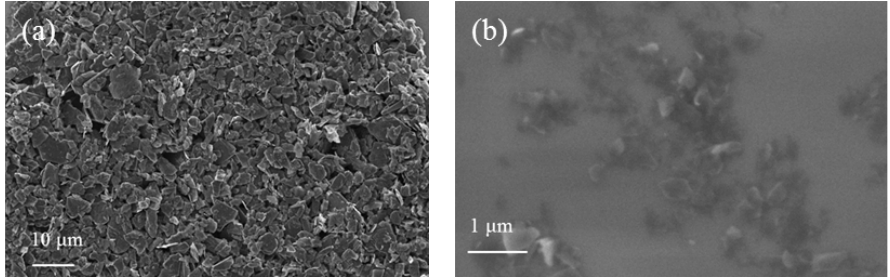
Figure 4. SEM images of ( a ) pristine graphite; ( b ) exfoliated graphene samples.